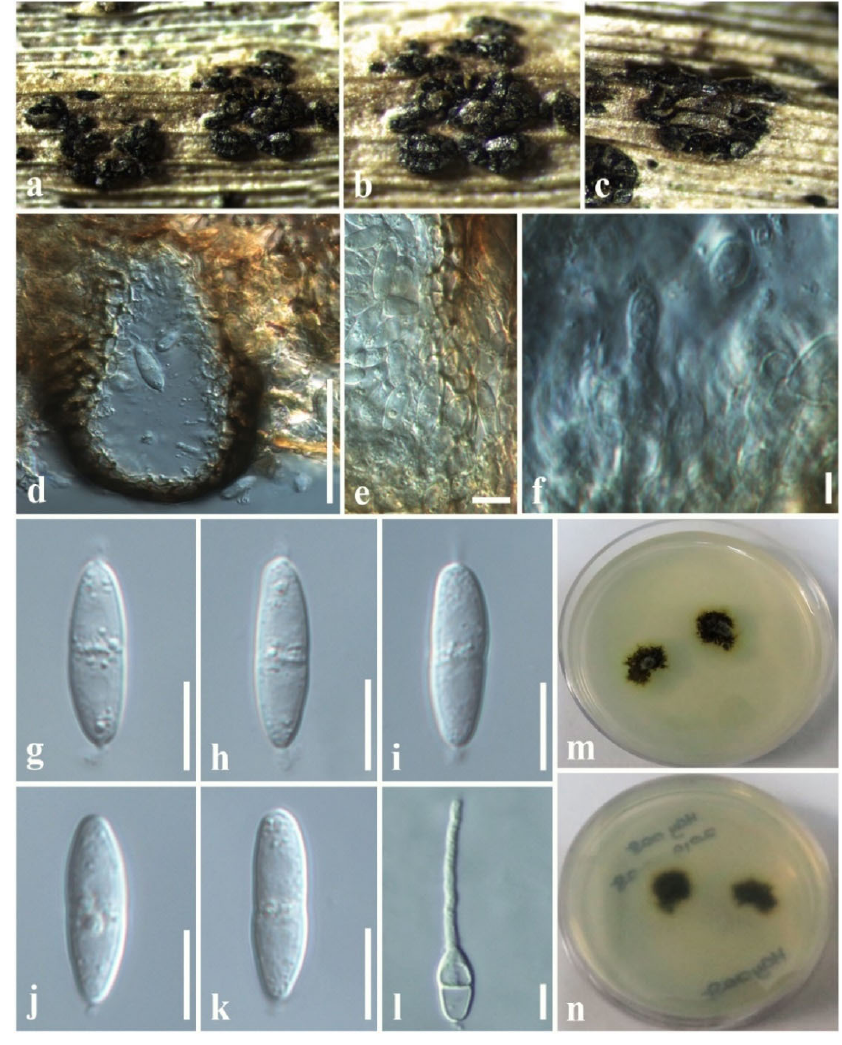
Figure 6. Sphaerellopsis paraphysata (MFLU 19 ‐ 2774, new host record). ( a , b ) Conidiomata on host. ( c ) Close ‐ up of conidiomata on host. ( d ) Section through conidioma. ( e ) Conidiomatal wall. ( f ) Conidiogenous cells with developing conidia. ( g – k ) Conidia. ( l ) A germinating conidium. ( m ) Colony from above (on PDA). ( n ) Colony from below (on PDA). Scale bars: ( d ) = 50 μ m, ( e , f ) = 5 μ m, ( g – l ) = 8 μ m.